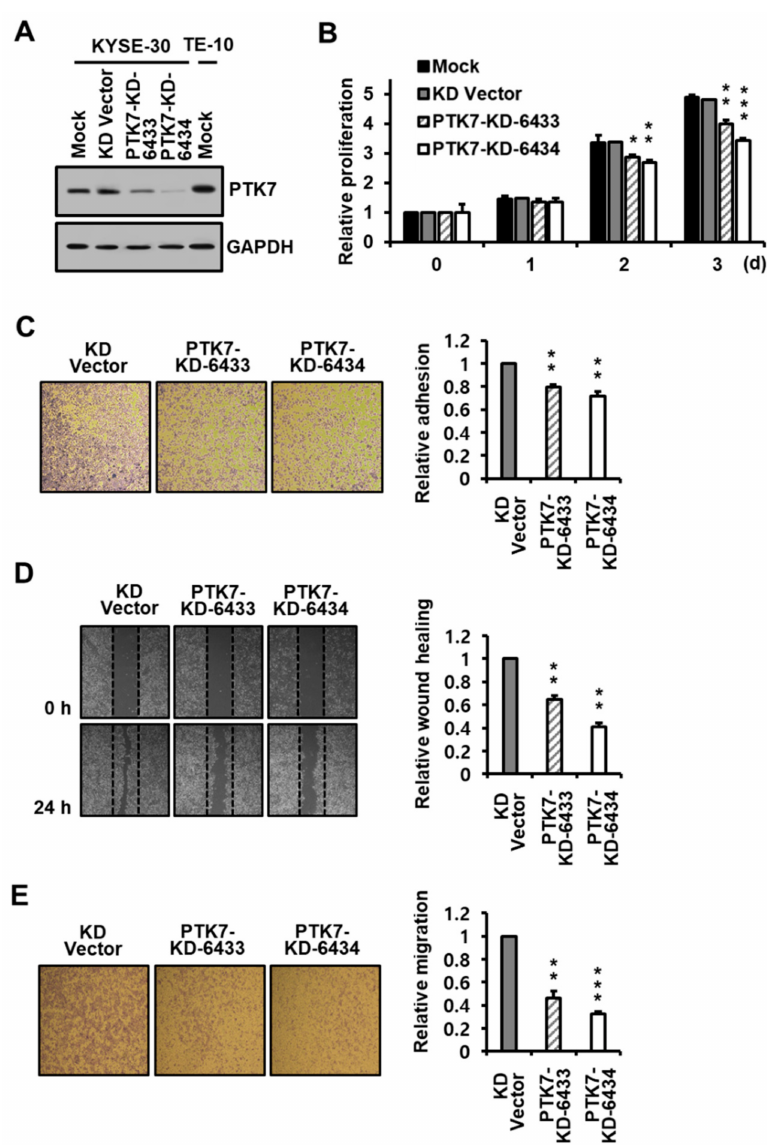
(Figure 2A), and PTK7 knockdown using PTK7-KD-6433 and -6434 decreased cell prolif- eration to 398.1 ± 14.4% and 341.9 ± 9.4%, respectively, compared to that by the vector control at 482.1 ± 14.2%, after 3 days of culturing (Figure 2B). PTK7 knockdown using PTK7-KD-6433 and -6434 also reduced adhesion to 80.9 ± 2.3% and 69.5 ± 1.6% (Figure 2C), wound healing to 65.0 ± 3.1% and 41.2 ± 3.2% (Figure 2D), and migration to 46.4 ± 5.7% and 32.5 ± 2.0% (Figure 2E), respectively, in comparison to that by the knockdown vec- tor control. PTK7 overexpression and knockdown exhibited an opposing effect on the tumorigenic effect, indicating that PTK7 acts as an oncogene in KYSE-30 cells.